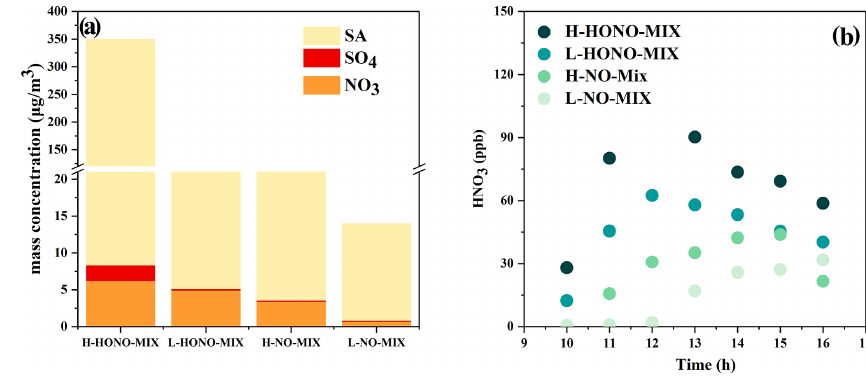
Figure 6. (a) The measured mass concentration of sulfate, nitrate, and total secondary aerosol in the particle phase. The data used in this plot are the average of the hour in which the mass concentration was the greatest. SA is the abbreviation of secondary aerosol. (b) The concentration of gas-phase nitric acid in the mixture system.